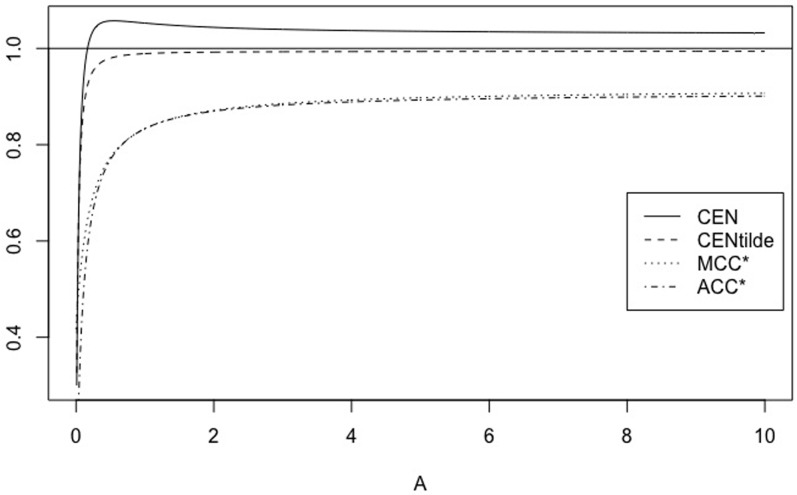
Family XA, r.CEN, MCEN, ACC* and MCC* as function of A > 0 for r = 5.